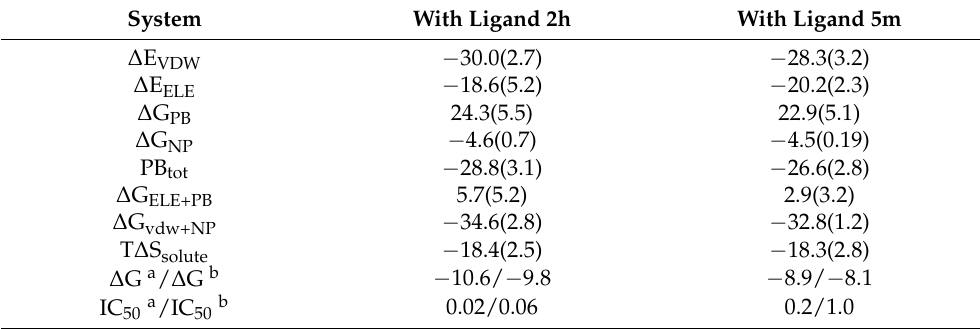
Table 2. Experimental and calculated binding free energies of compounds 2h and 5m to the BVDV RdRps. Energies are in kcal/mol; IC 50 values are in µ M. The experimental ∆ G bind values are estimated from IC 50 data with the equation ∆ G bind = RT ln IC 50 (R is the universal gas constant, T = 298.5 K), while the calculated values are given by the formula: ∆ G bind = ∆ E ELE + ∆ E VDW + ∆ G PB + ∆ G NP − T ∆ S conf . The various contributions are also shown. a Calculated value, b experimental